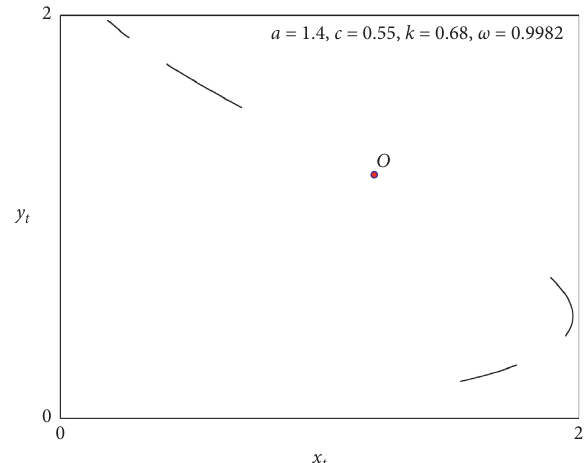
Figure 6: The phase plane of a chaotic attractor consisting of four bands at the parameters’ values, a � 1 . 4 ,c � 0 . 55 ,k � 0 . 68, and ω � 0 .